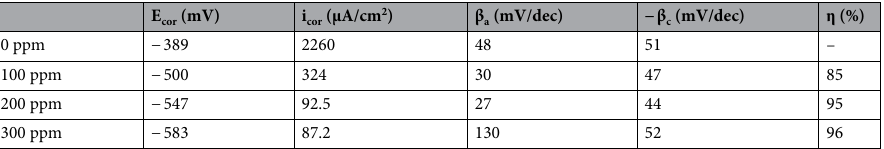
Table 3. Electrochemical data obtained from polarization measurements of the MS specimens dipped in HCl solution containing different concentrations of GSE at 25 °C.